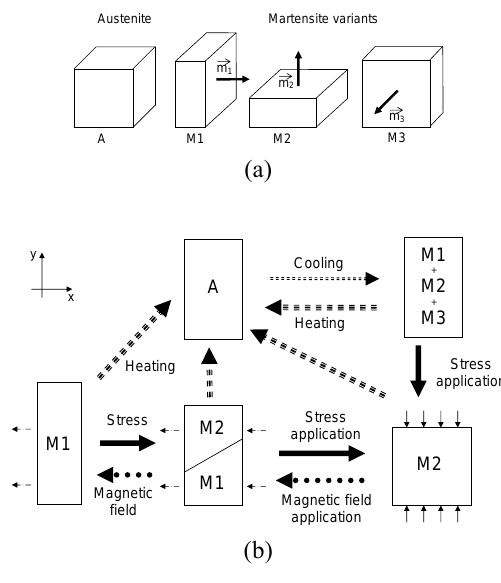
Figure 1: MSMA behaviour: (a) austenite phase and the three martensite variants and (b) martensitic reorientation: effects of mechanical stress, magnetic field and tempera-